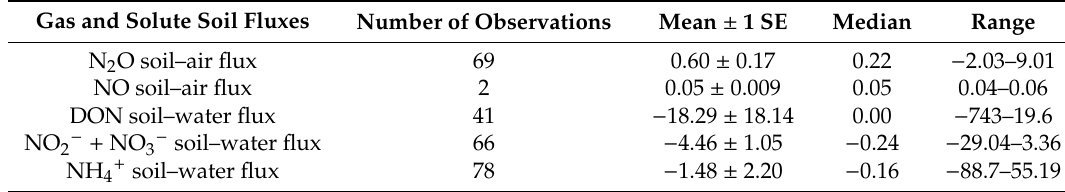
Table 4. Estimates of net NO and N 2 O gas and dissolved nitrogen fluxes across the mangrove soil